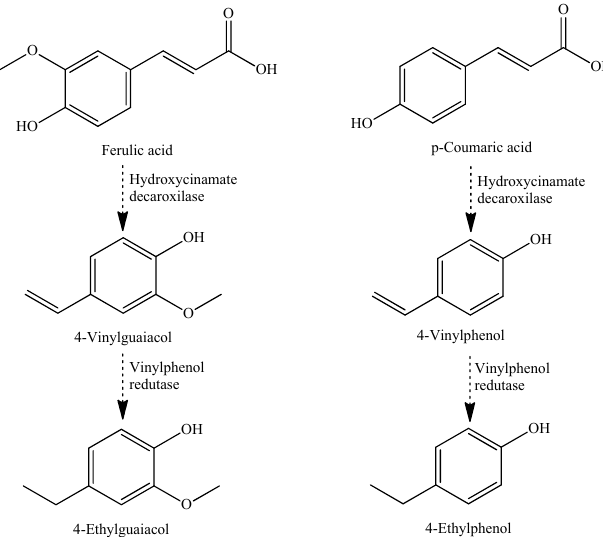
Figure 6. Formation of ethylphenols from hydrocinnamic precursors by yeast transformation (e.g., Brettanomyces and Dekkera) [97].